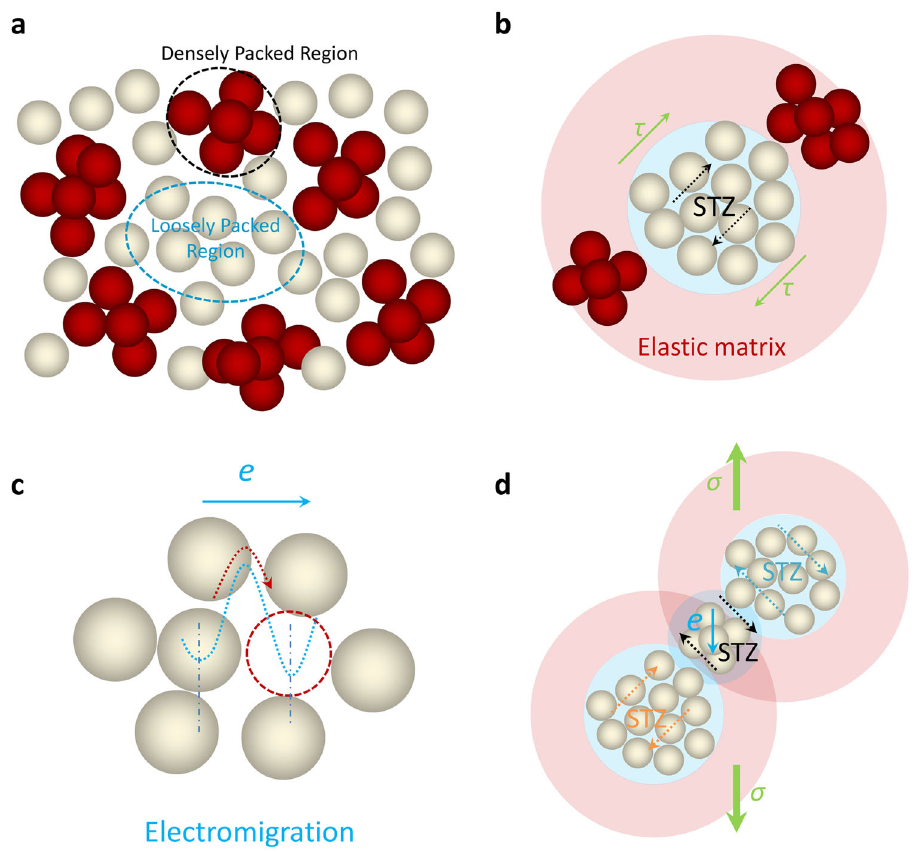
Fig. 5 Illustration on the dynamic rejuvenation of bulk metallic glasses (BMGs) driven by the electron-scattering force in electromigration. a Randomly distributed densely packed regions which contain less free volume (red spheres), and loosely packed regions which contain more free volume (white spheres), for the existence of free volume in BMGs. b Under external loading, the atoms in soft loosely packed regions develop into shear transformation zones (STZs) to carry plastic deformation by participating in shear transformation, while the atoms in strong densely packed regions act as an elastic matrix and con fi ne the STZs. The atoms in densely packed regions do not participate in shear transformation, and do not contribute to plastic deformation. c Atomic diffusion promoted by the electron-scattering force along the direction of electron transport in electromigration, where the more densely packed atoms suffer a larger force. This atomic diffusion is virtually the free volume-based fl ow mechanism of BMGs. d The electron-scattering force preferentially drives the atoms in the strong densely packed regions, which con fi ne STZs to participate in shear transformation and contribute to plastic deformation, i.e. creates bond-switching events, thus promoting homogeneously distributed